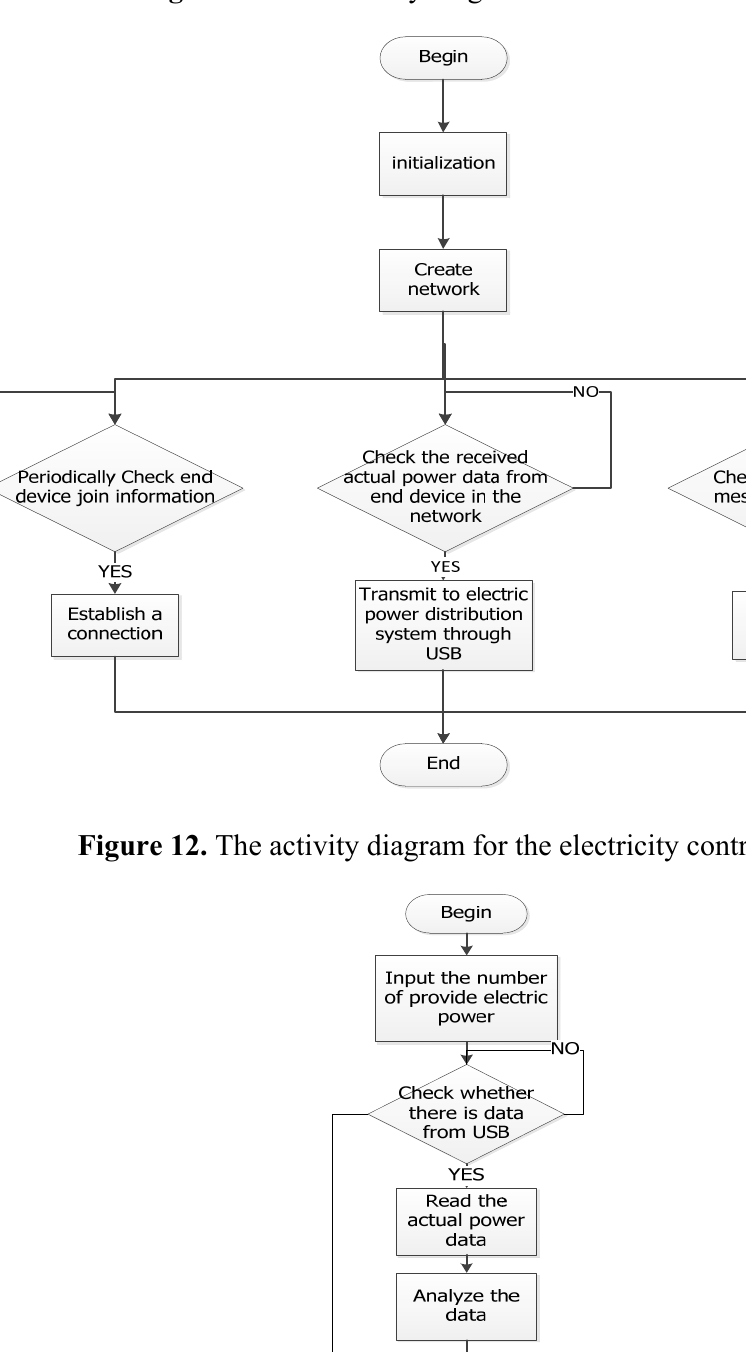
Figure 11. The activity diagram for the coordinator.